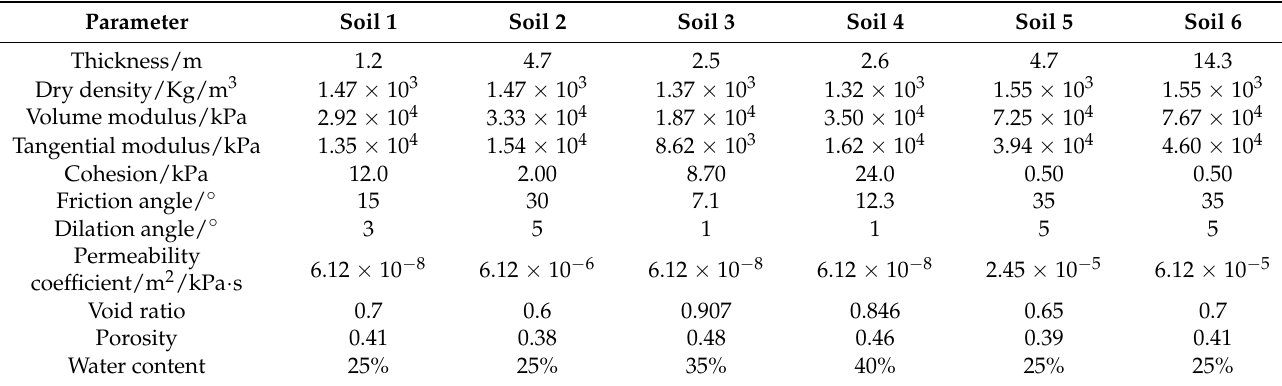
Figure 17. The boundary conditions for flow and displacements.